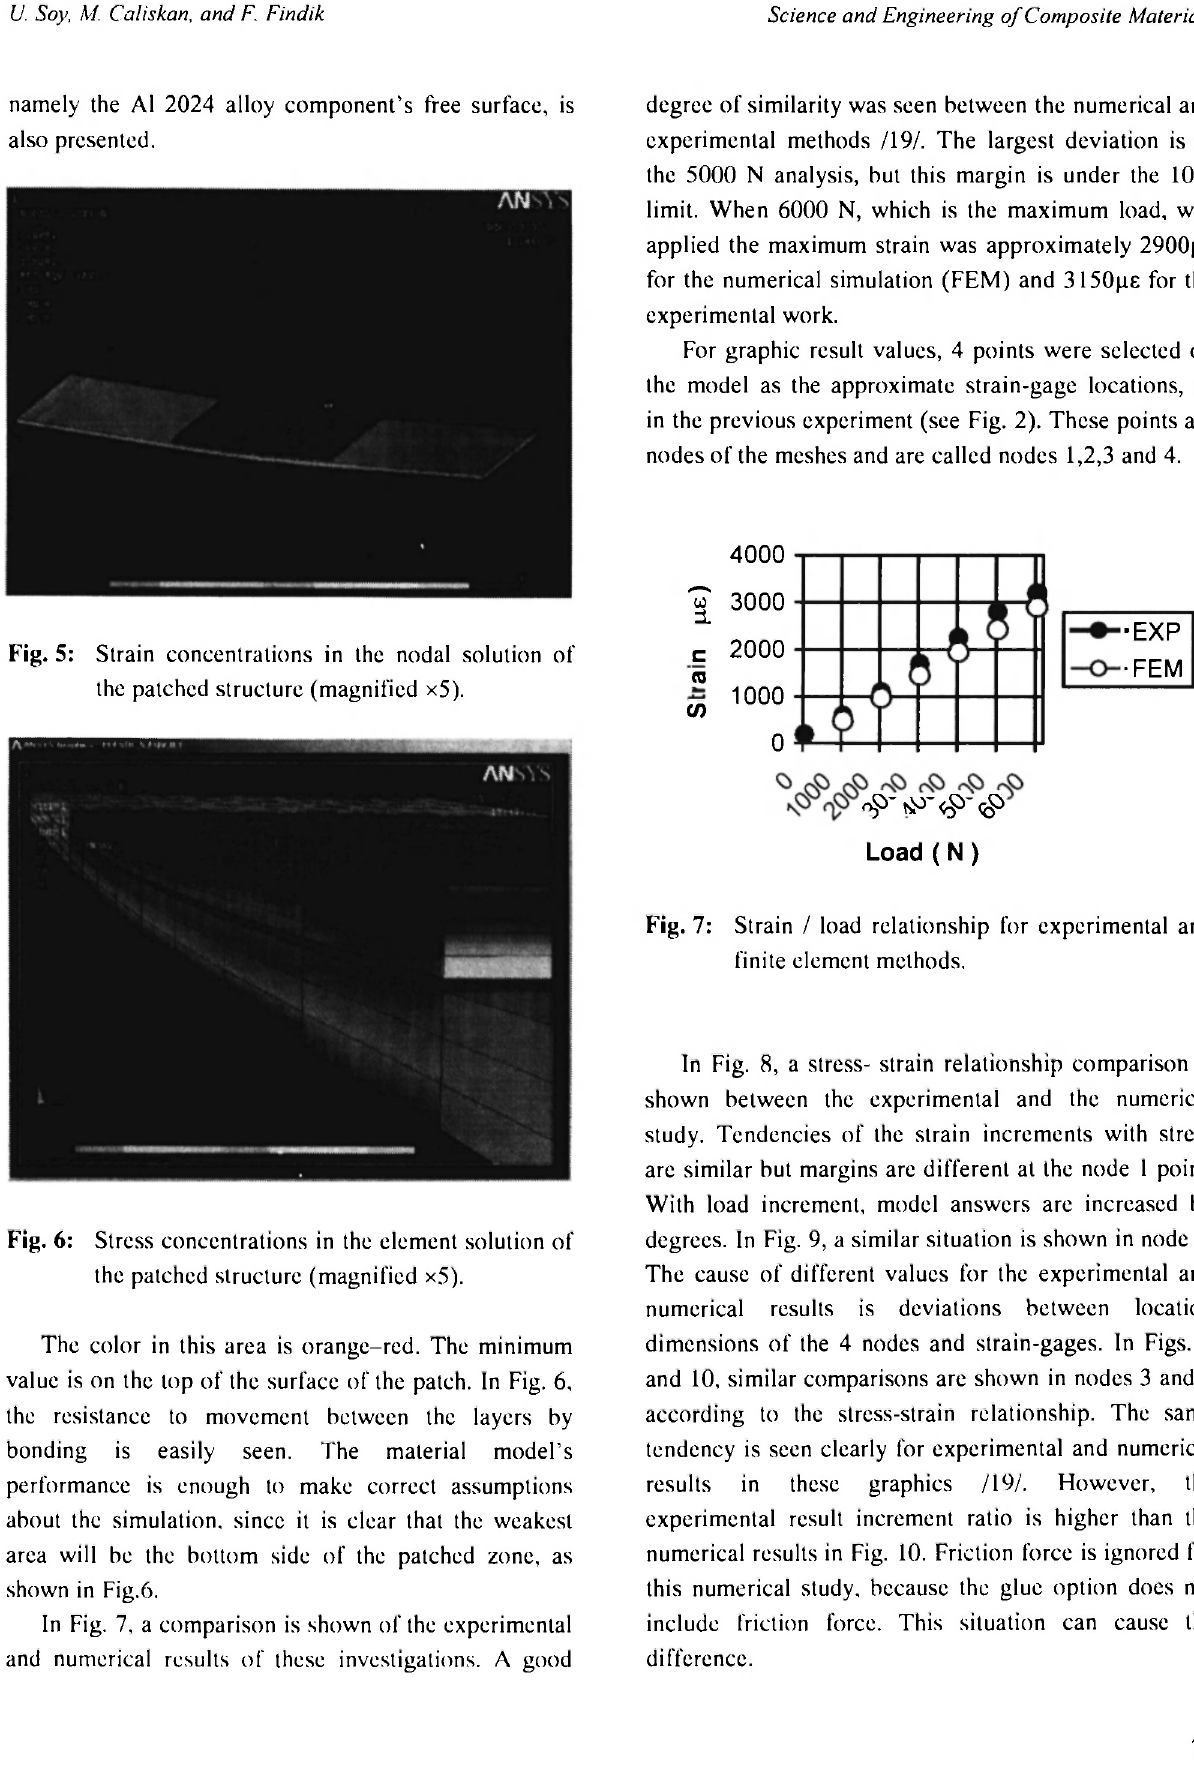
Fig. 6: Stress concentrations in the element solution of the patched structure (magnified x5).